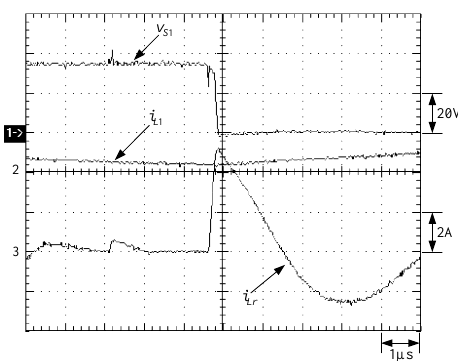
Figure 27. Waveforms pertaining to L r and C r at the rated load: (1) i Lr ; and (2) v Cr .